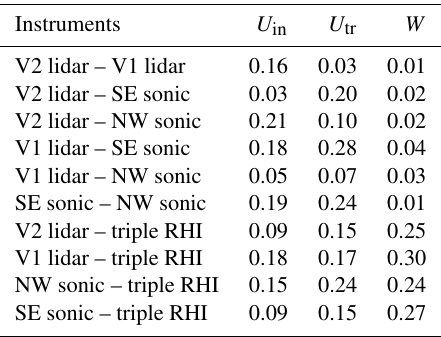
Table 7. Mean square value of the difference between velocities measured from different instruments.